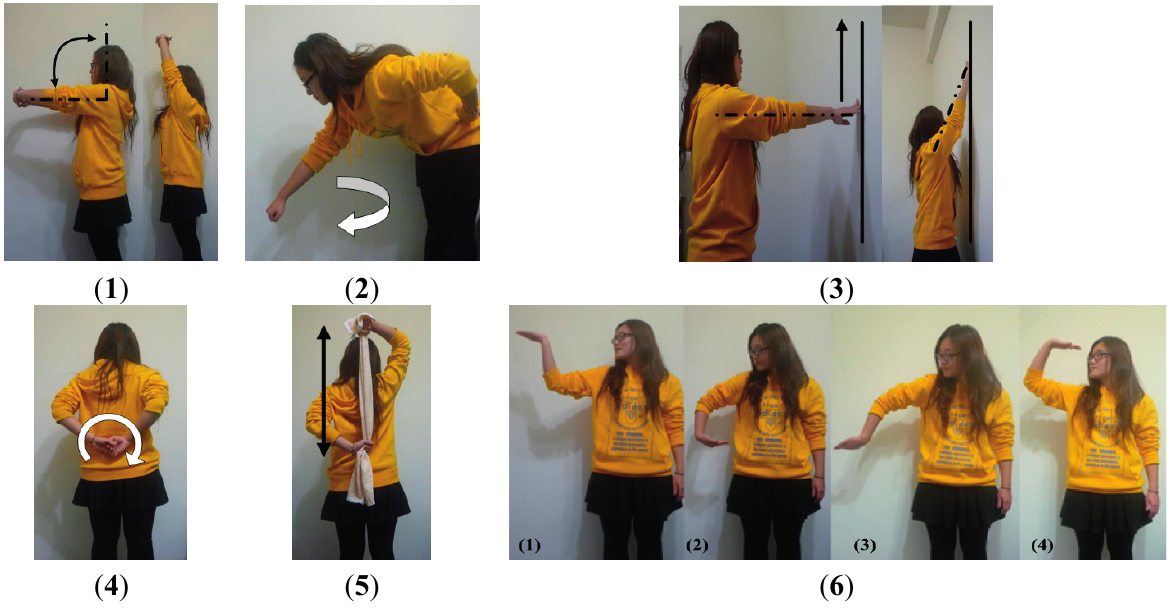
Figure 2. Rehabilitation exercises for frozen shoulder: ( 1 ) scapula exercise; ( 2 ) Codman’s pendulum exercise; ( 3 ) finger wall-climbing exercise; ( 4 ) back shoulder circling exercise; ( 5 ) towel exercise; and ( 6 ) spiral rotation exercise in four